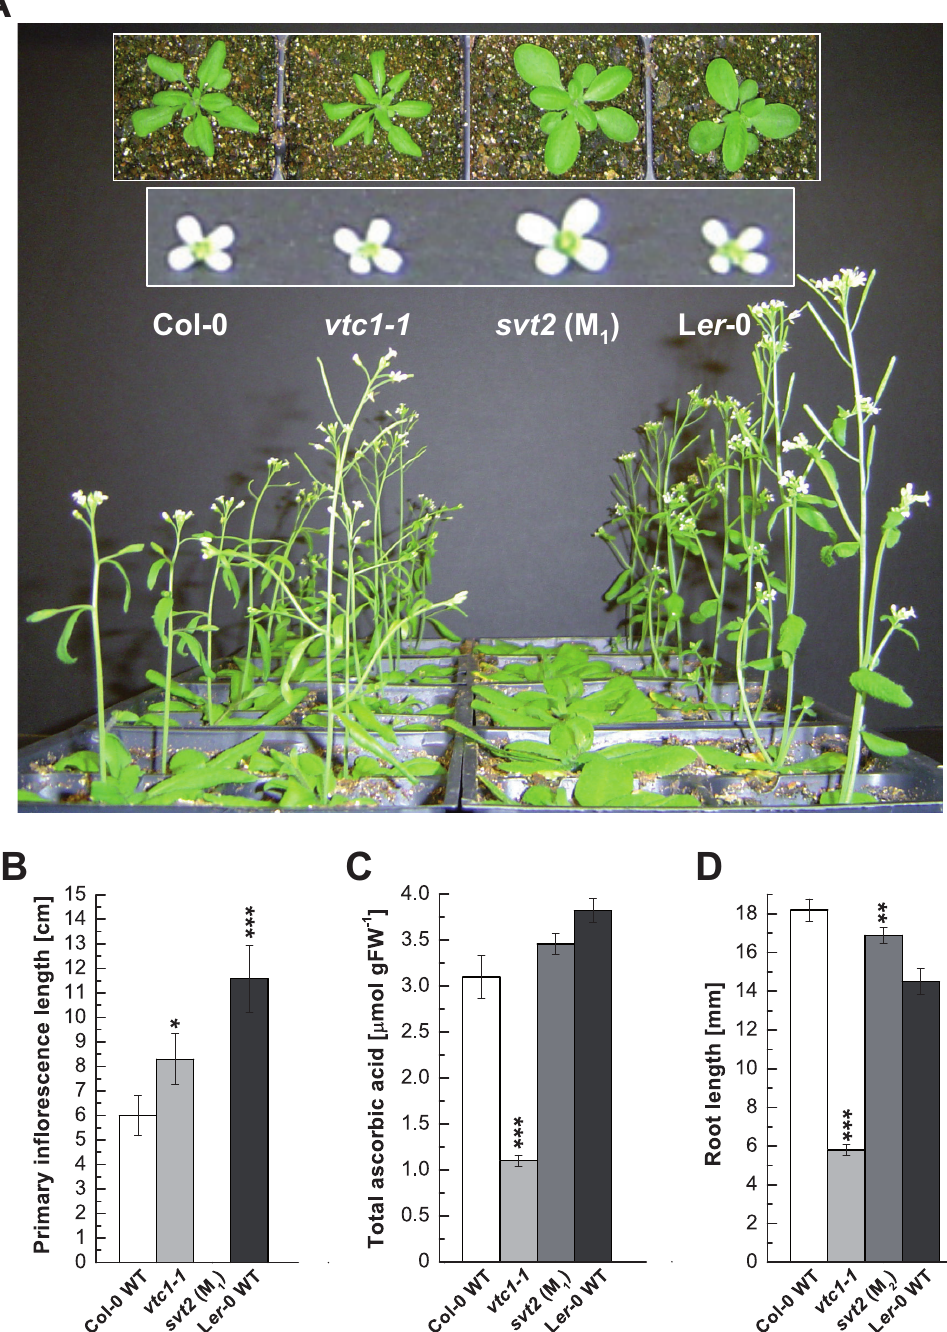
Figure 3. Phenotypic characterization of svt2 . ( A ) Flowering phenotype of four-week-old Col-0 wild type, the vtc1-1 and svt2 mutants and the L er -0 wild type. Insets show rosette phenotypes of the four genotypes when plants were three weeks old and the flower phenotype of six-week-old plants, respectively. ( B ) Primary inflorescence length when plants were four weeks old. Bars represent means ± SE of eight individual replicates. ( C ) Total ascorbic acid content per gram fresh weight in whole rosettes of three-week-old plants. Bars represent means ± SE of three individual replicates. ( D ) Root length in seven-day-old seedlings grown on 1× MS. Bars represent means ± SE of 30-90 individuals. * P < 0.05, ** P < 0.01, *** P < 0.001 by Student’s t -test indicate significant differences in comparison to Col-0 and L er -0 wild type,